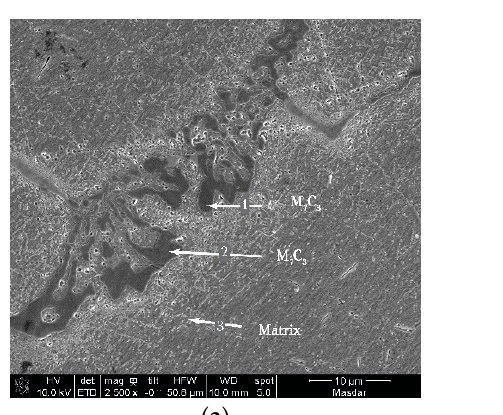
Figure 3. Microstructure revealed by metallography: ( a ) Condition L, ( b ) condition M, ( c ) condition H, ( d ) condition X, and ( e ) condition H5.